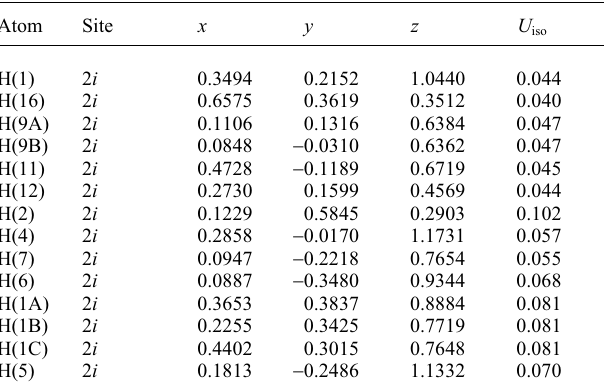
Table 2. Atomic coordinates and displacement parameters (in Å 2 )